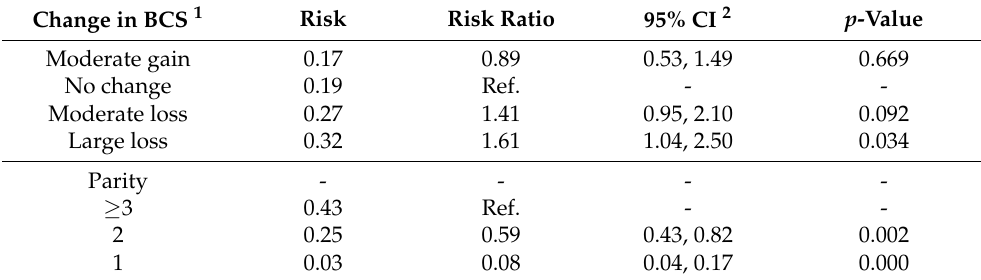
Table 3. Association between change in BCS and HYK in early lactation, adjusted by